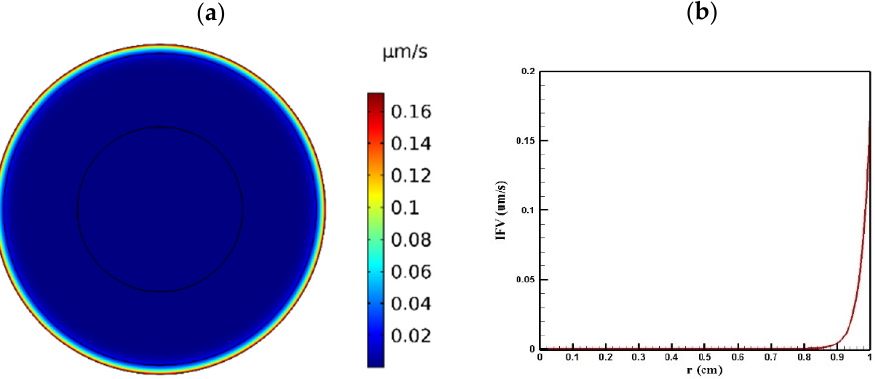
Figure 4. IFP distribution in a tumor with a radius of 10 mm: ( a ) contour of IFP distribution in the tumor; ( b ) IFP distribution values along the tumor radius.